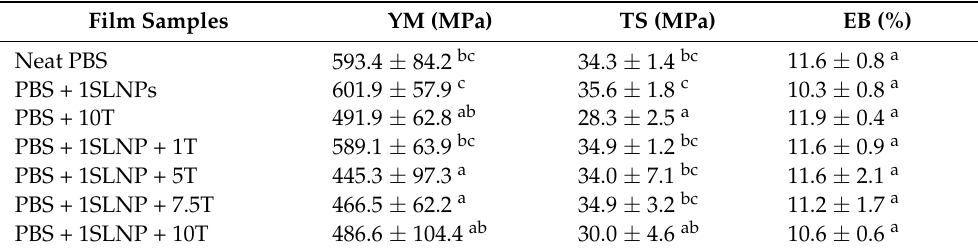
Table 3. Young’s modulus (YM), tensile strength (TS), and elongation at break (EB) in the machine direction of neat PBS and PBS composite